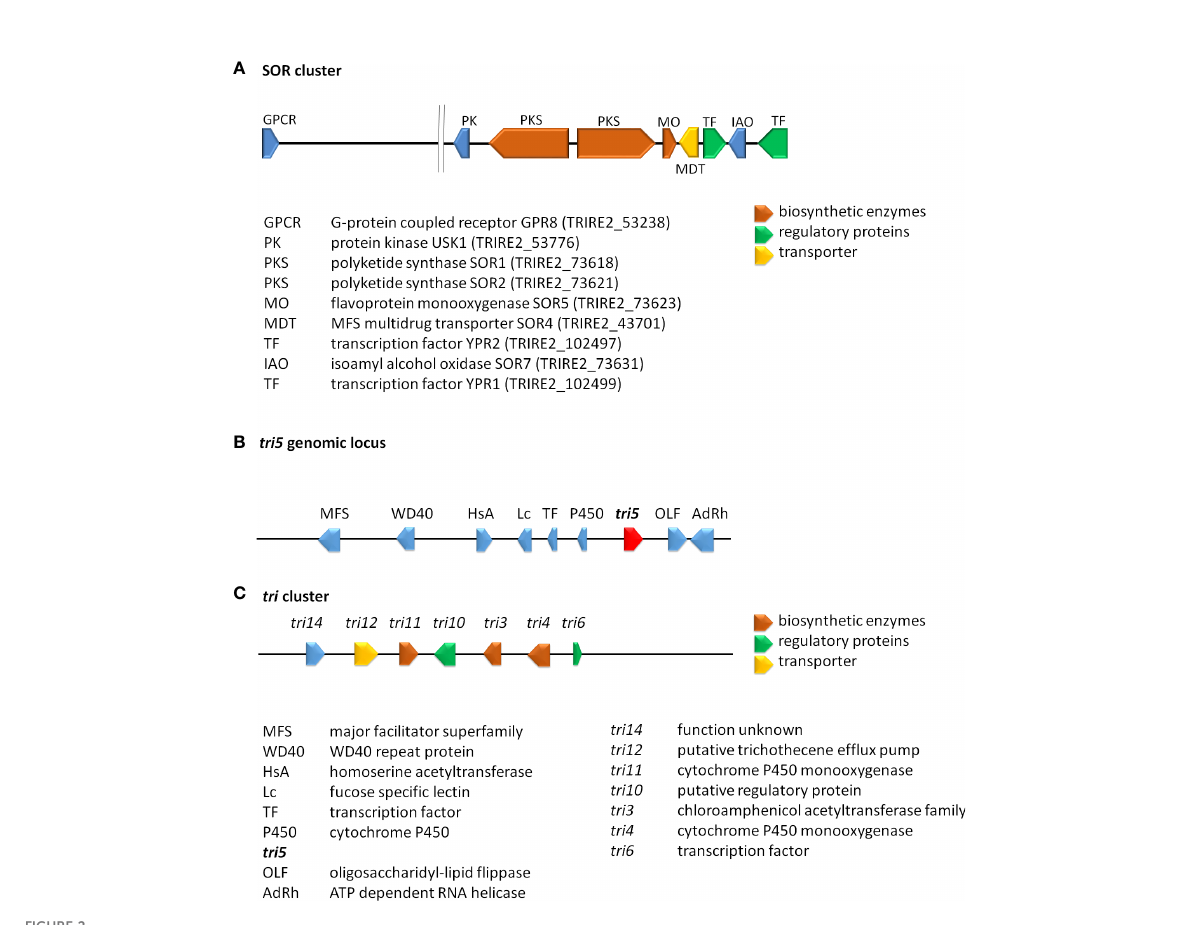
FIGURE 2 Schematic representation of selected secondary metabolite clusters in Trichoderma . (A) The SOR cluster in T. reesei along with characterized fl anking genes. Functions and JGI protein IDs ( T. reesei v2.0) are listed below the scheme. (B) The genomic locus of tri5 in T. arundinaceum and T. brevicompactum (Gutierrez et al., 2021). (C) The tri cluster in T. arundinaceum (Cardoza et al., 2011). Encoded proteins of the tri cluster and the tri5 genomic locus are given below the